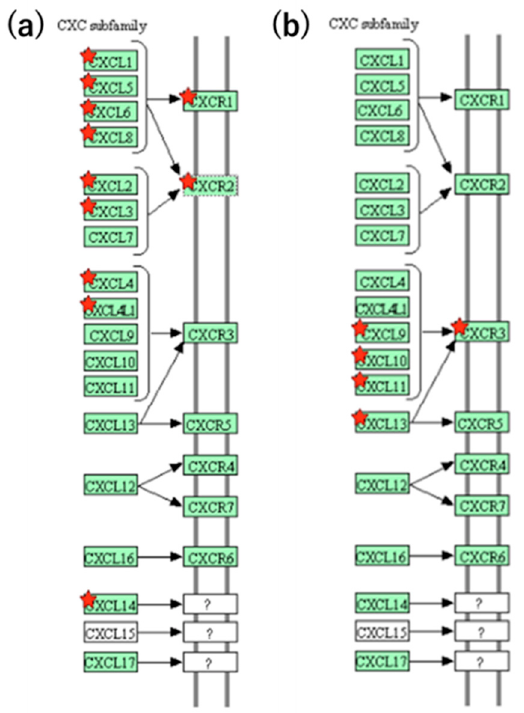
Figure 2. Association of CXC subfamily pathways in renal cell carcinoma (adrenal cancer cells). ( a ) Adrenal cancer cells. ( b ) Renal cell carcinoma. Red star: Expression-variable genes on the pathway.